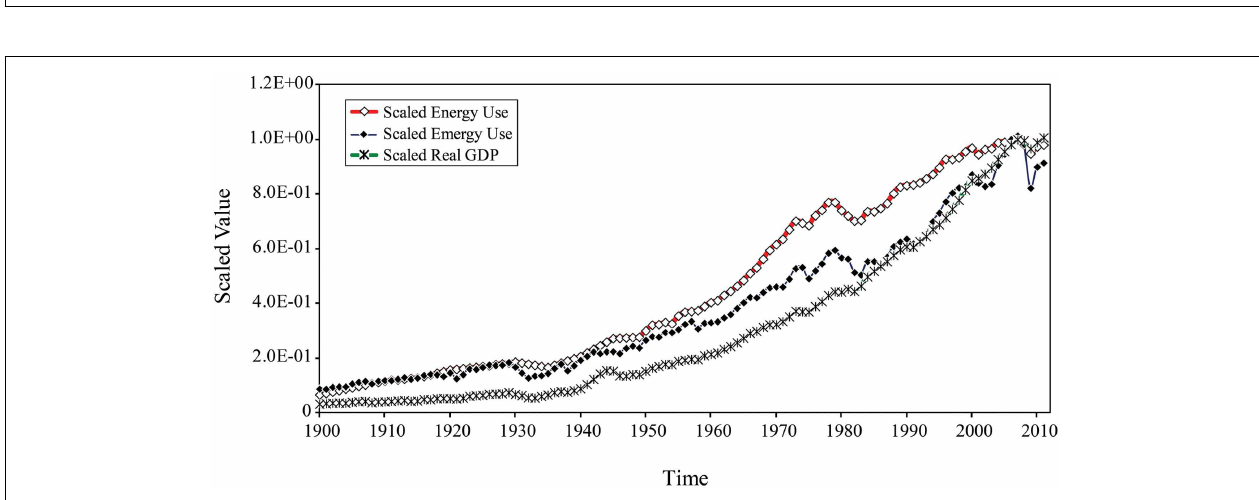
FIGURE 15 | Structural change in the U.S. economy from 1900 to 2011 as indicated by changes in the scaled values of energy consumption (Emergy QA), total emergy use, and real GDP